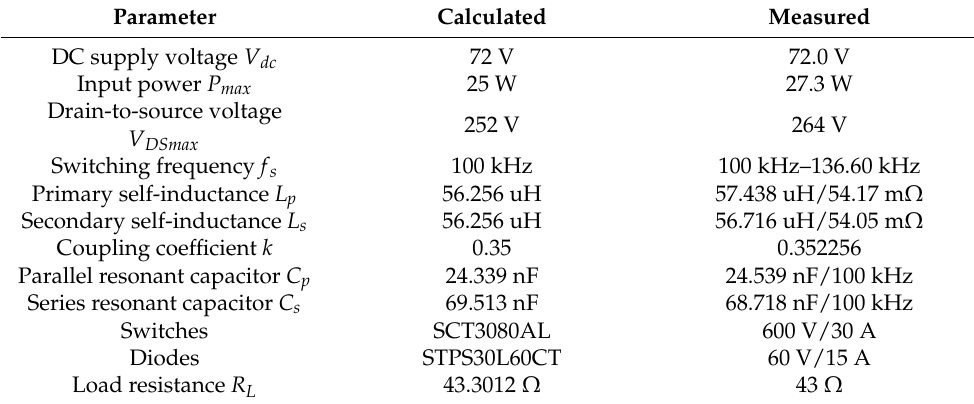
Table 1. Value of components used in simulation and experiments.